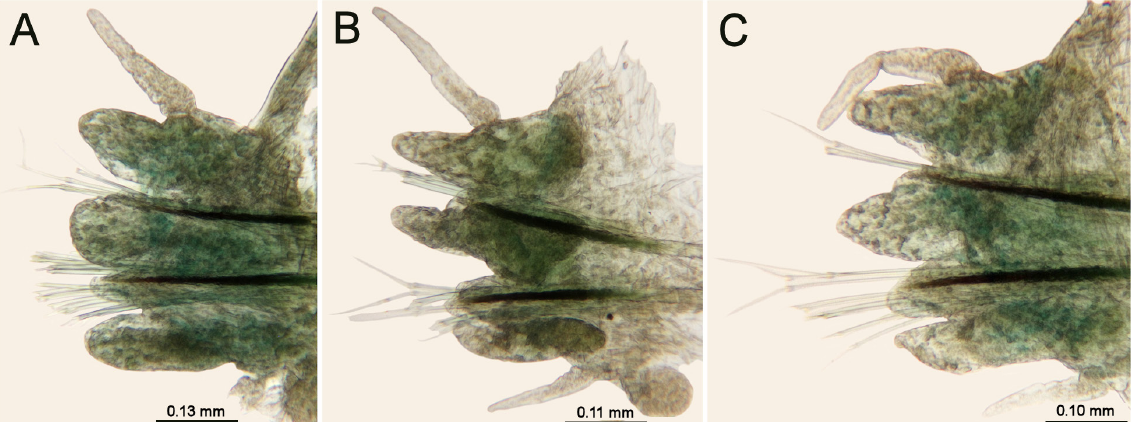
Fig. 1. Nereis splendida Grube, 1840, non-type juvenile (MNHN 423-531), after methyl green staining. A . Chaetiger 9, right parapodium, anterior view. B . Chaetiger 25, right parapodium, anterior view. C . Chaetiger 46, right parapodium, anterior